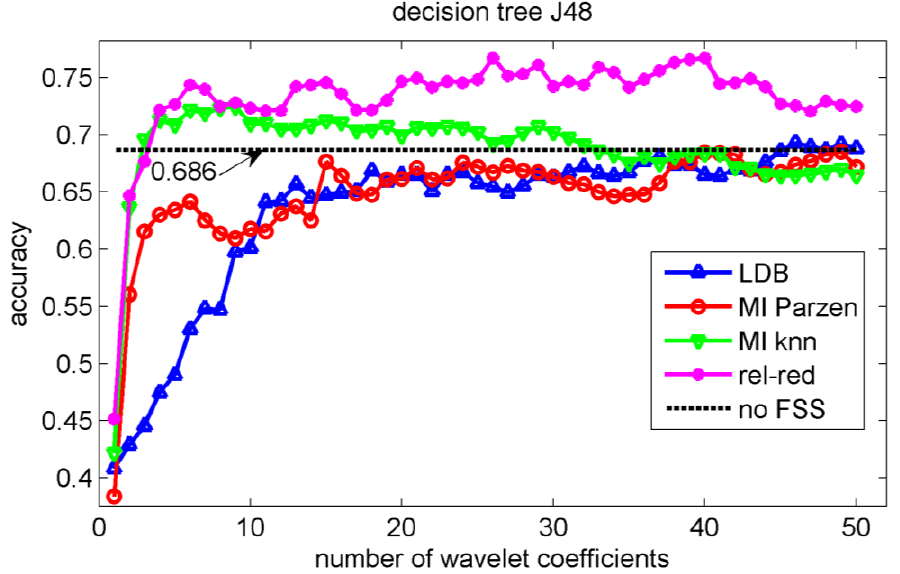
Figure 6. Evolution of the accuracy of the decision tree J48 classifier as a function of the number of wavelet coefficients selected with the LDB algorithm and the mutual information filter algorithms. The horizontal line indicates the accuracy when all 1,024 samples are